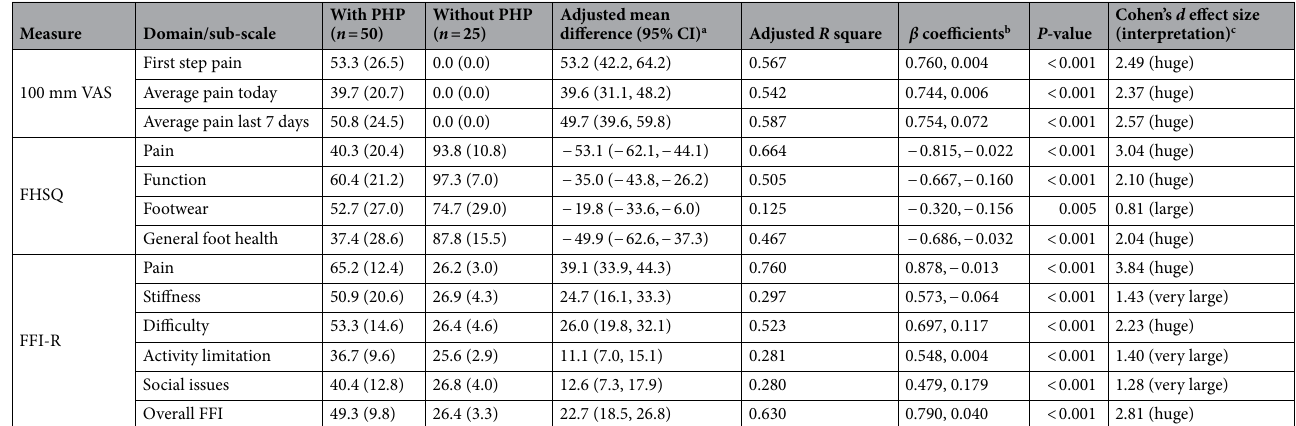
Table 4. Comparison of foot-specific health-related quality of life in participants with and without PHP— values are means (SDs). For the VAS , a score of 0 represents no pain and a score of 100 represents the worst pain imaginable. For the FHSQ , scores range from 0 to 100 with lower scores indicating poorer foot health status and higher scores indicating better foot health status for an individual. For the FFI‑R , scores range from 0 to 100 with lower scores indicating better foot health status and higher scores indicating poorer health status for an individual (note: this scoring is opposite to the FHSQ and SF‑36 ). VAS Visual Analogue Scale, FHSQ Foot Health Status Questionnaire, FFI‑R Foot Function Index—Revised. a Mean difference adjusted for the covariate osteoarthritis. b Two standardised β coefficients are provided—the first for group (i.e. with or without PHP) and the second for the covariate (i.e. comorbidity) osteoarthritis. c Interpretations for the Cohen’s d effect sizes were taken from Sawilowsky 49